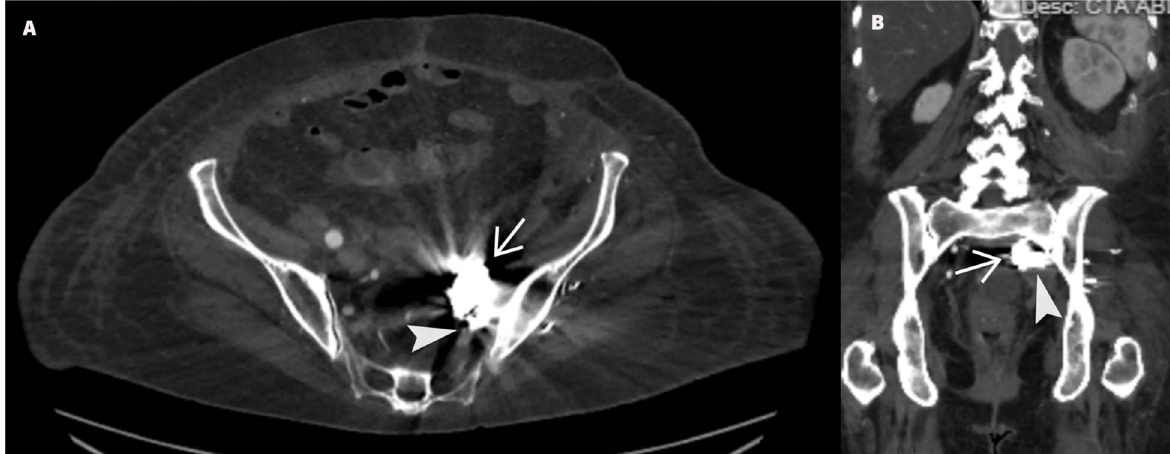
Fig. 5 Follow up CT angiogram of the embolized left internal iliac artery mycotic pseudoaneurysm. A ) Axial CT image and B ) MPR coronal CT image of completely embolized left internal iliac artery mycotic pseudoaneurysm with onyx (arrow) coils (arrowhead) without contrast in the